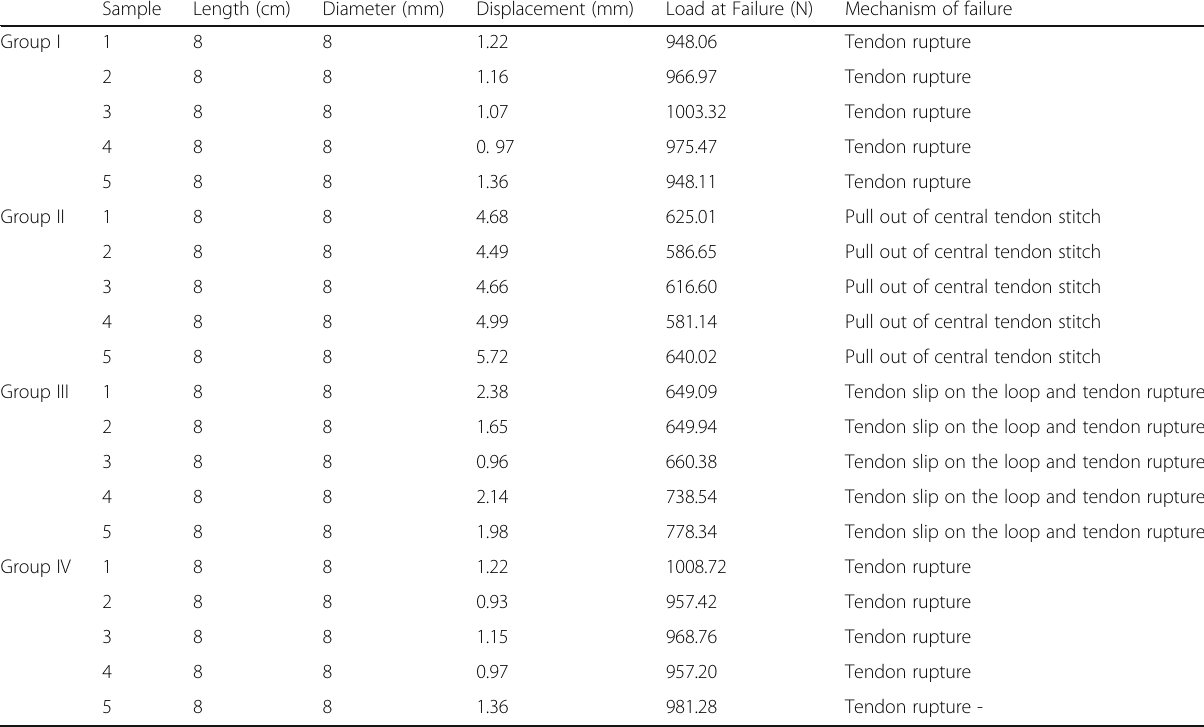
Table 1 Load at failure and the mechanism of failure of all samples Sample